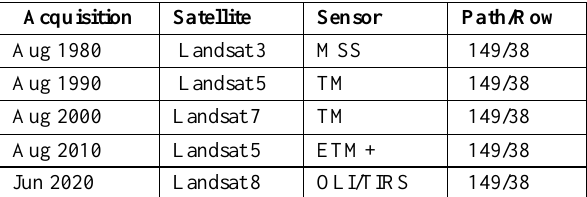
Table 1. Datasets Used.